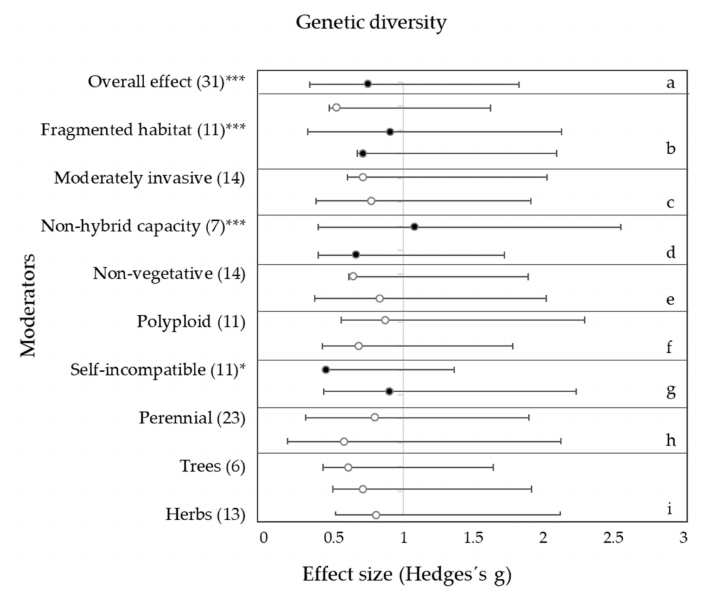
Figure 3. Effect sizes on genetic diversity: ( a ) overall effect, ( b ) habitat condition, ( c ) invasiveness, ( d ) hybrid capacity, ( e ) vegetative propagation, ( f ) ploidy level, ( g ) mating systems, ( h ) lifespan, ( i ) life form (mean and 95% CI; numbers in parentheses represent sample size; * p < 0.05, *** p < 0.001; not significant, p ≥ 0.05). Black dots represent a significant effect on genetic